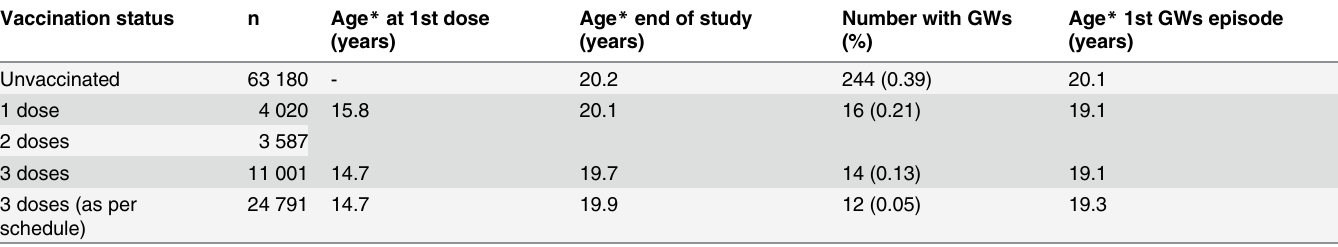
Table 2. Characteristics of the vaccine effectiveness study population as a function of their vaccination status.